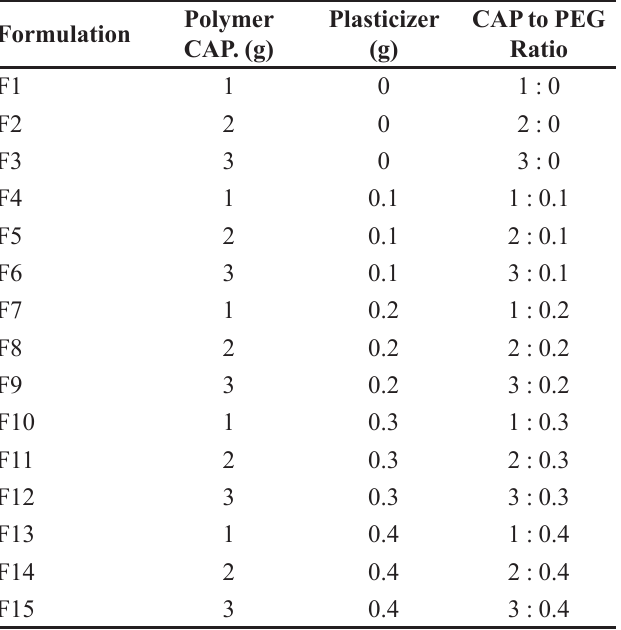
TABLE I - Composition of formulations with drug, polymer and plasticizer Formulation